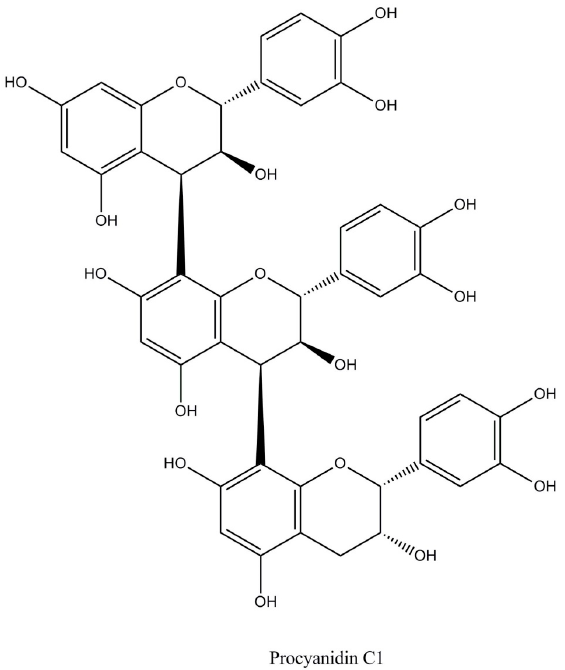
Figure 3. Proanthocyanidins-trimers in cocoa.